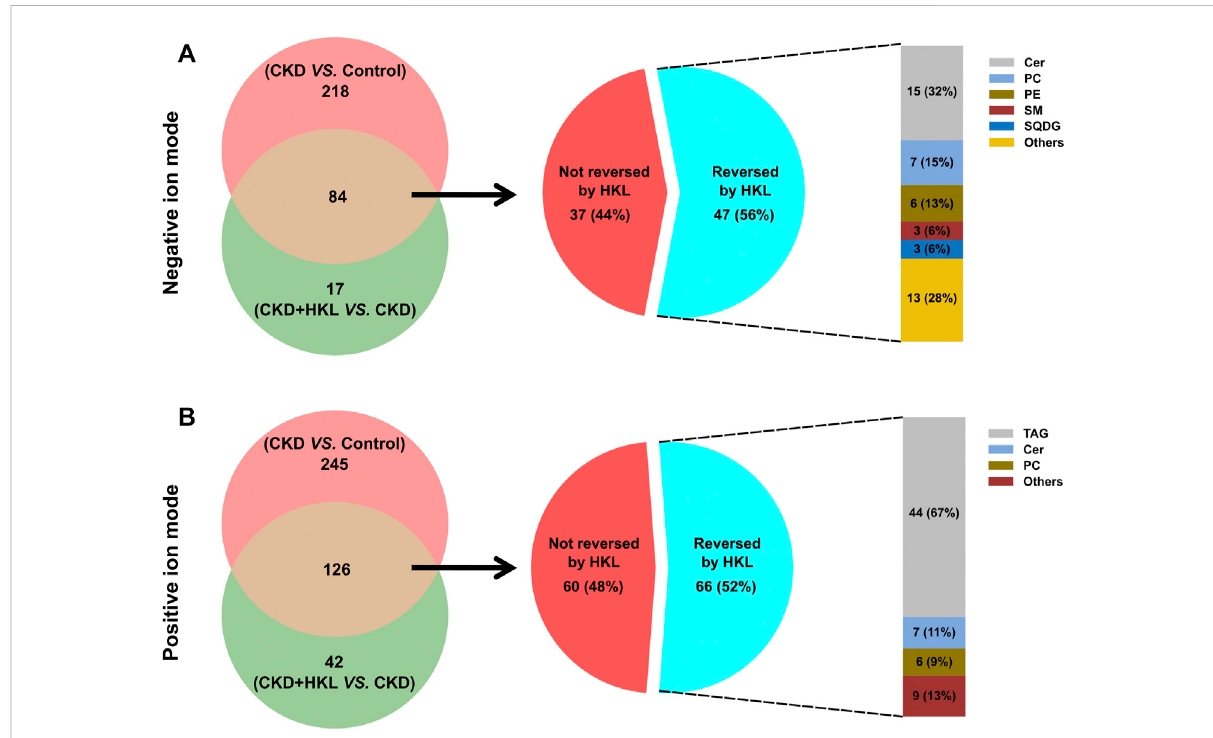
FIGURE 7 ScreeningoflipidsthatcouldbereversedbyHKLtreatmentinCKDrats. (A) Theamountandclassi fi cationoflipidsthatcouldbereversedbyHKL treatment in negative ion mode. (B) The amount and classi fi cation of lipids that could be reversed by HKL treatment in positive ion